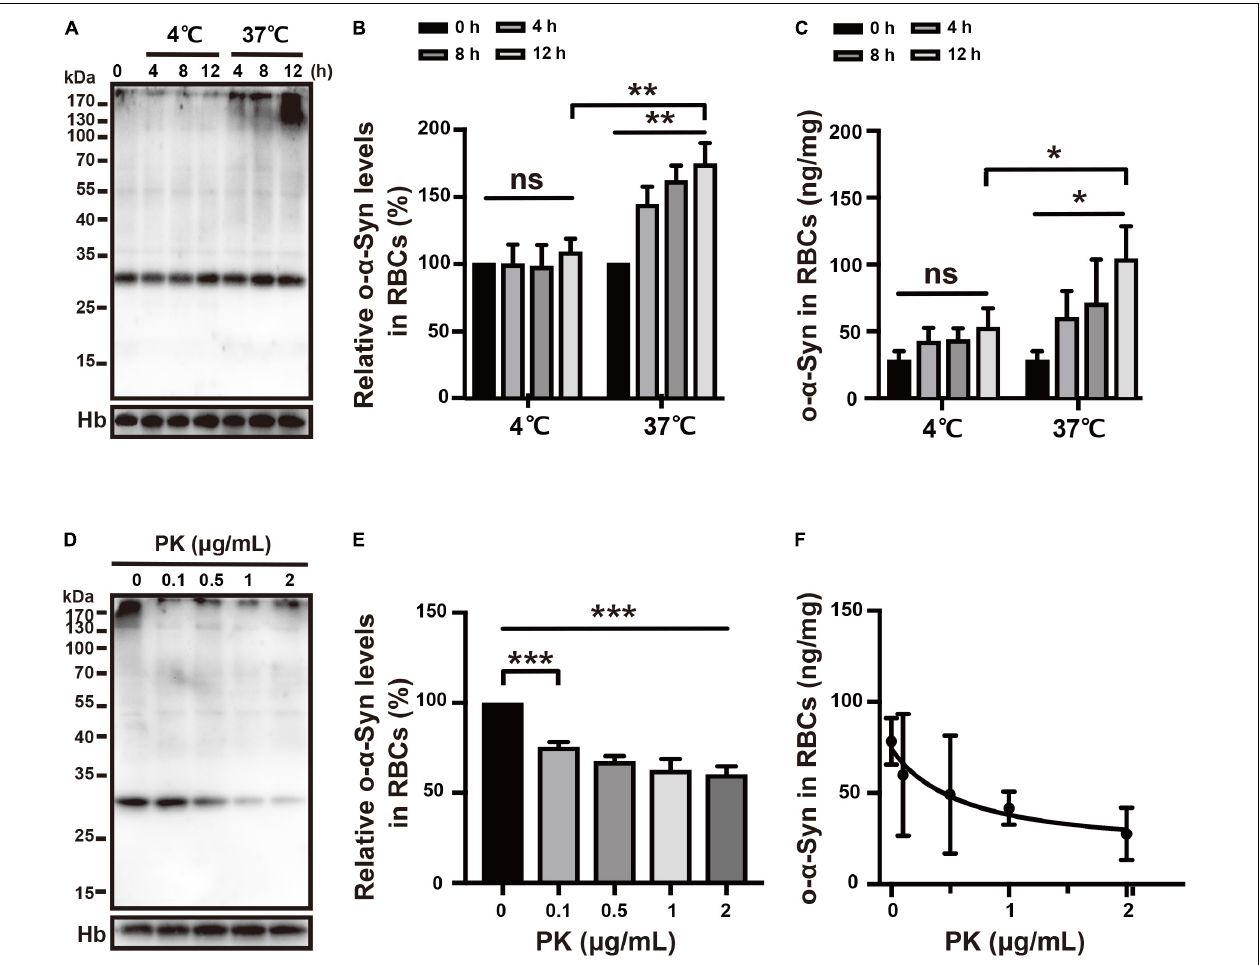
FIGURE 5 | Effects of temperature and PK on o- α -Syn transport into RBCs. (A–C) Lowering the temperature impaired intracellular o- α -Syn accumulation after extracellular addition of o- α -Syn. (D–F) Pretreating RBCs with PK decreased intracellular o- α -Syn accumulation; PK concentration and intracellular o- α -Syn accumulation negatively correlated ( r = –0.9184, p < 0.05). n = 3; * p < 0.05, ** p < 0.01, *** p < 0.001; ns, not significant. Hb,